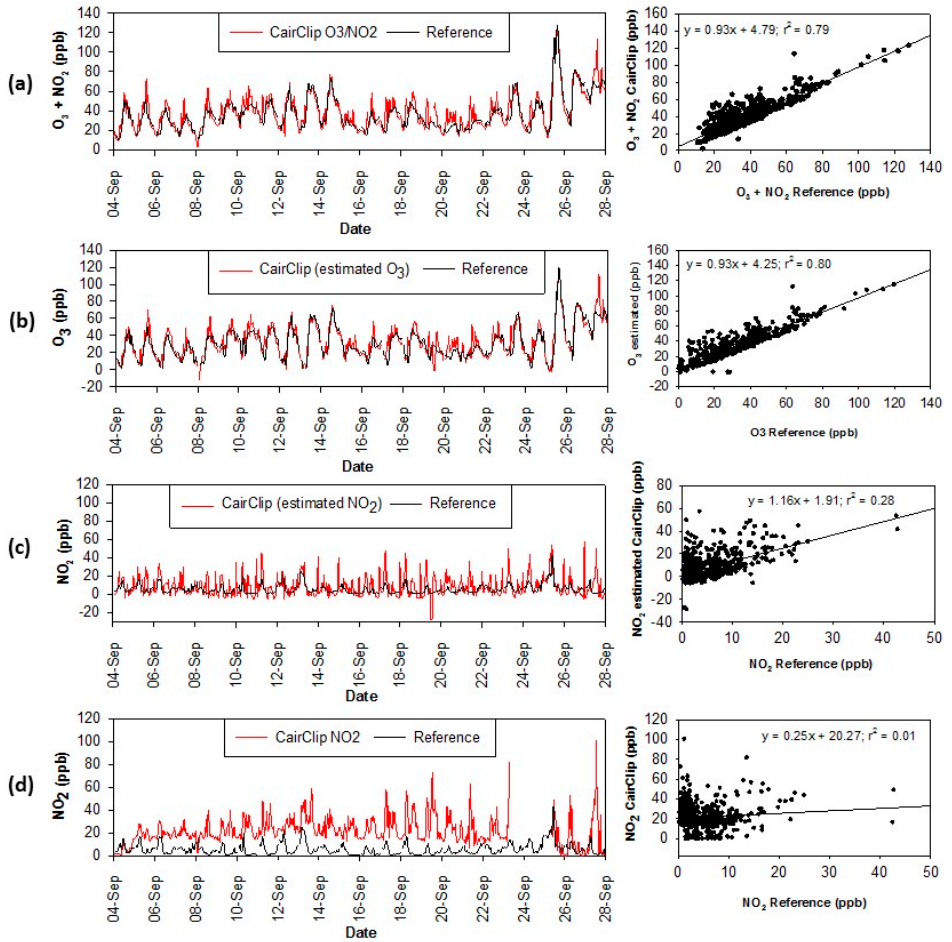
Figure 4. Time series and scatter plots of hourly average reference measurements during the Houston campaign compared to the ( a ) CairClip O 3 /NO 2 sensor; ( b ) estimated O 3 values for the CairClip O 3 /NO 2 sensor; ( c ) estimated NO 2 values for the CairClip O 3 /NO 2 sensor; and ( d ) CairClip NO 2